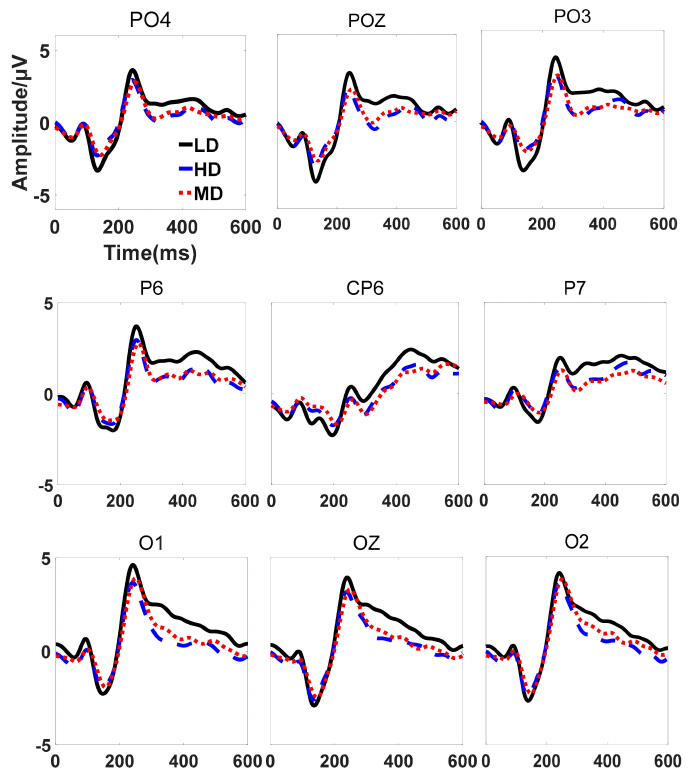
Figure 4. The comparison of ERP amplitude changes of some channels under di ff erent mental workload